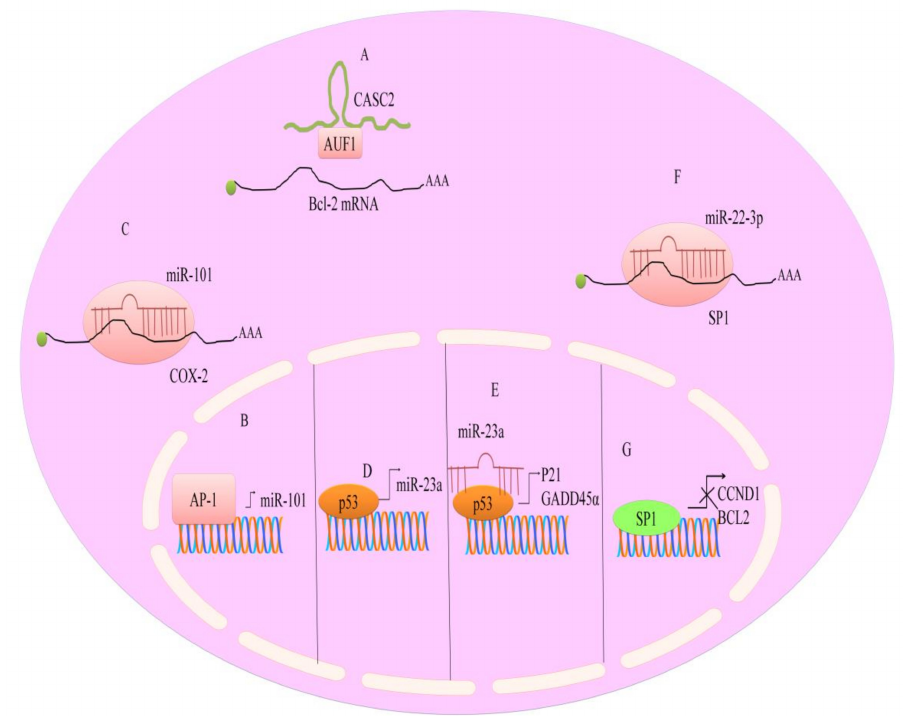
Figure3. Regulation ofnon-coding RNAsby berberine. ( A ) CASC2interacted withAUF1 and prevented itsbindingtoAUrichsequencespresentwithinmRNAofBcl-2. ( B , C )AP-1transcriptionallyupregulated miR-101. miR-101 directly targeted COX-2. ( D – G ) P53 induced transcriptional upregulation of miR-23a. Additionally, miR-23a worked synchronously and stimulated the expression of GADD45a and p21. miR-22-3p directly targeted SP1. SP1 mediated upregulation of CCND1 and BCL2. Abbreviations: AUF1 (AU-rich element RNA-binding protein-1), BCL2 (B-cell CLL / lymphoma-2), GADD45 α (Growth arrest- and DNA damage-inducible gene), CCND1 (Cyclin D1), CASC2 (long non-coding RNA), SP1 (specificity protein-1), AP-1 (Activator